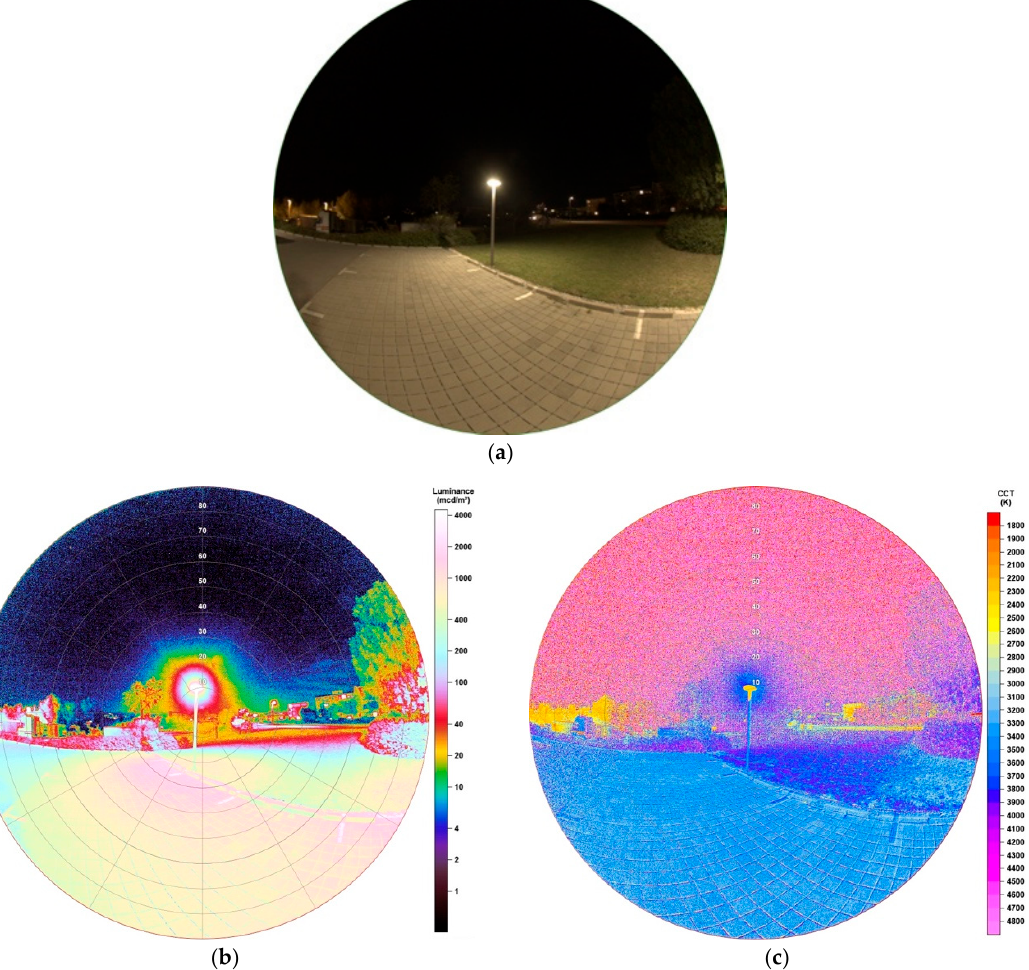
Figure 12. ( a ) Image of ring-shaped lamp during night-time taken with fisheye lens for detailed analysis (date: 24.10.2019, 20:52 h; exposure time: 0.3 s); ( b ) Luminance matrix of image (a) as displayed by SQC; ( c ) CCT matrix of image (a) as displayed by SQC.